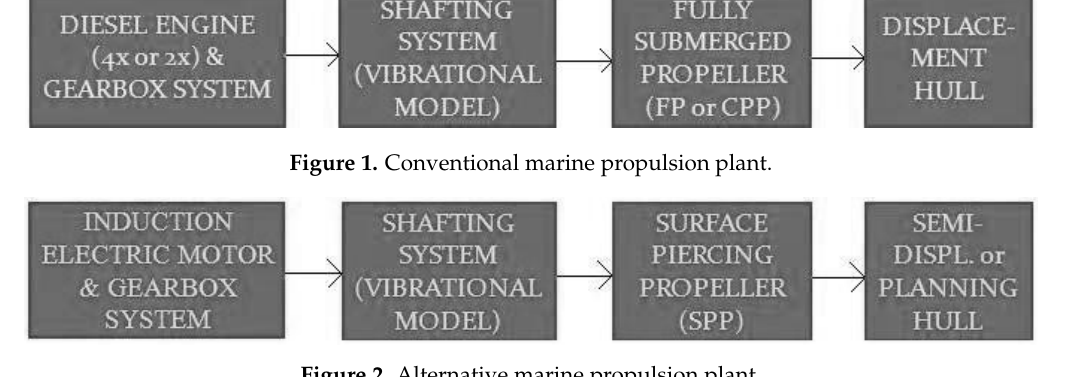
Figure 2. Alternative marine propulsion plant.